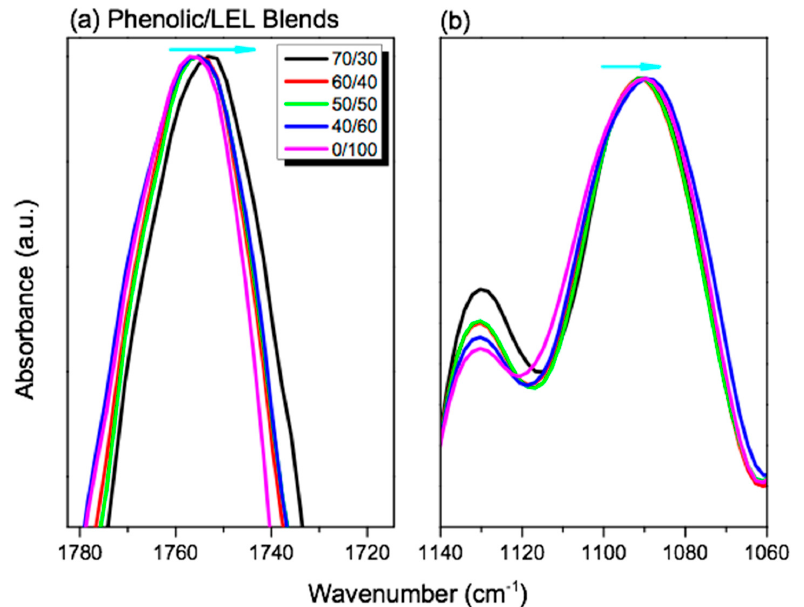
Figure 2. ( a ) C = O and ( b ) C–O–C absorptions of various phenolic / LEL blends based on FTIR spectra Figure 2. ( a ) C=O and ( b ) C–O–C absorptions of various phenolic/LEL blends based on FTIR spectra recorded at room temperature. recorded at room temperature. Polymers 2020 , 12 , x FOR PEER REVIEW